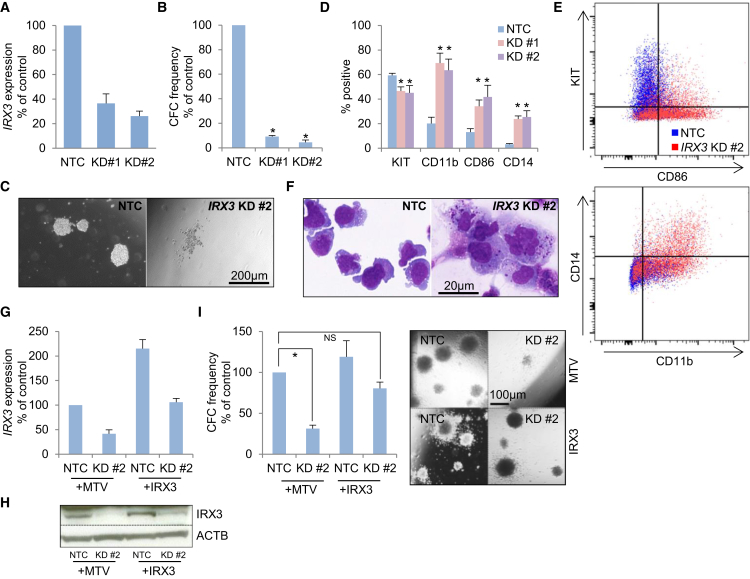
IRX3 Sustains the Differentiation Block and Clonogenic Potential of AML CellsHuman THP1 AML cells were infected with lentiviral vectors targeting IRX3 for KD or a non-targeting control vector (NTC).(A) Bar chart shows mean + SEM relative transcript expression in IRX3 KD versus control cells (n = 3) after 48 hr.(B) Bar chart shows the mean + SEM colony-forming cell (CFC) frequencies of KD cells relative to control cells enumerated after 10 days in semi-solid culture (n = 4).(C) Representative images of colonies of cells from (B).(D) Bar chart shows mean + SEM percentage of cells positive for the indicated cell surface markers, as determined by flow cytometry analysis 6 days following initiation of KD (n = 4). ∗p ≤ 0.05 using one-way ANOVA with Fisher’s least significant difference post hoc analysis for KD conditions versus NTC.(E) Representative flow cytometry plots from (D).(F) Representative images of cytospins of cells from (D).(G) Bar chart shows mean + SEM relative transcript expression in THP1 AML cells expressing either IRX3 or a control retroviral vector (MTV) in IRX3 KD#2 cells relative to control cells (n = 3).(H) Western blot shows expression of the indicated proteins in the indicated conditions.(I) Bar chart (left) shows mean + SEM CFC frequencies of THP1 AML cells expressing either IRX3 or a control retroviral vector (MTV) in IRX3 KD#2 cells relative to control cells. Colonies were enumerated after 10 days in semi-solid culture (n = 4). Image (right) shows representative colonies. ∗p ≤ 0.05 using one-way ANOVA with Fisher’s least significant difference post hoc analysis for the indicated comparison. NS, not significant.See also Figure S4.